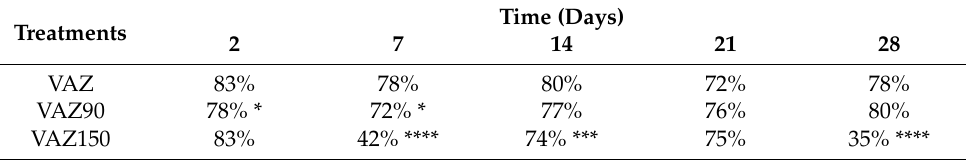
Table 4. Tail intensity (TI) median values during the ecotoxicological study. Time (Days) Treatments 2 7 14 21 28 VAZ 83% 78% 80% 72% 78% VAZ90 78%